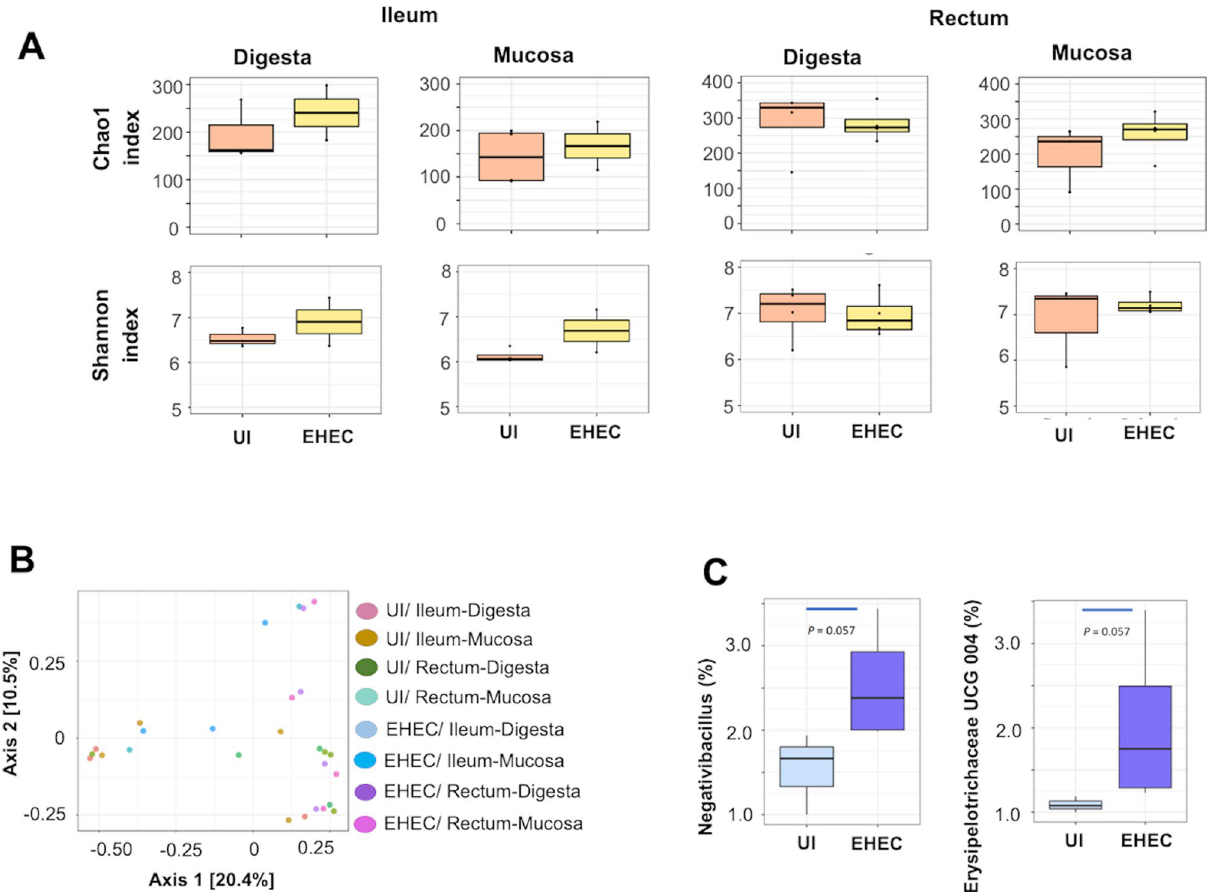
Figure 8. ( A ) Alpha diversity (Chao1 and Shannon index) in the ileum (mucosa-associated bacteria) and rectum (digesta and mucosa-associated bacteria) of calves uninfected (UI) or challenged by EHEC O157: H7 (EHEC). ( B ) Principle coordinate analysis (PCoA) based on Bray–Curtis distance in ileum and rectum (digest and mucosa-associated bacterial profiles) of calves uninfected (UI) or challenged by EHEC O157: H7 (EHEC). ( C ) The relative abundance of ( Negativibacillus and Erysipelotrichaceae UCG 004 (%) in the rectum (mucosa- associated bacteria) of calves uninfected (UI) or challenged by EHEC O157: H7